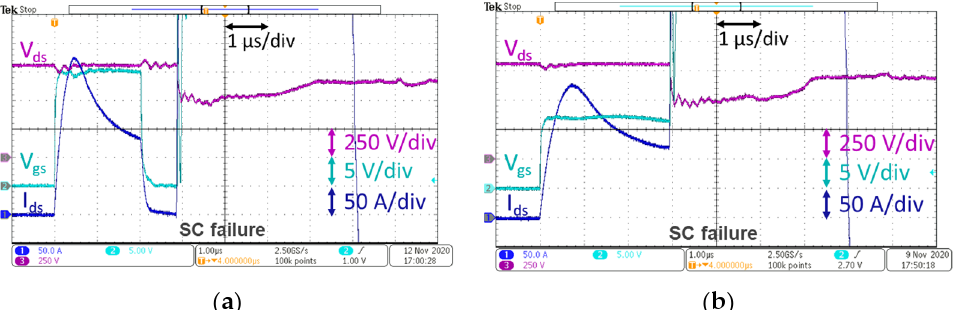
Figure 20. ( a ) Graph showing the SCWT variation with channel length; ( b ) the device short circuit test waveforms at room temperature with V gs-on = 20 V and V ds-off = 800 V; ( b1 ) L ch = 0.4 µm, ½W JFET = 0.6 µm; ( b2 ) L ch = 0.5 µm, ½W JFET = 0.6 µm ( b3 ) L ch = 1.0 µm, ½W JFET = 0.6 µm.